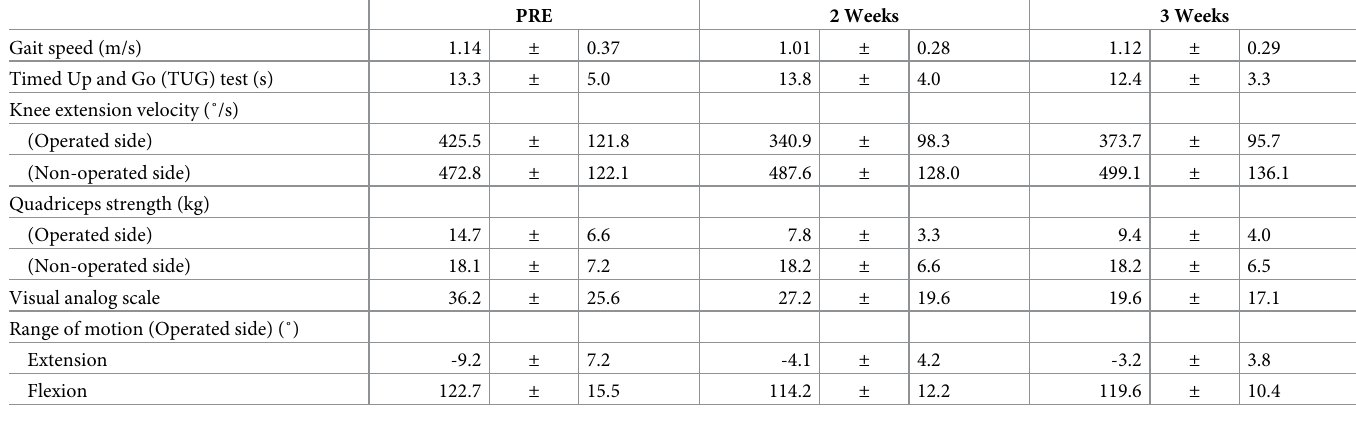
Table 2. Changes in gait and knee function over time (n =